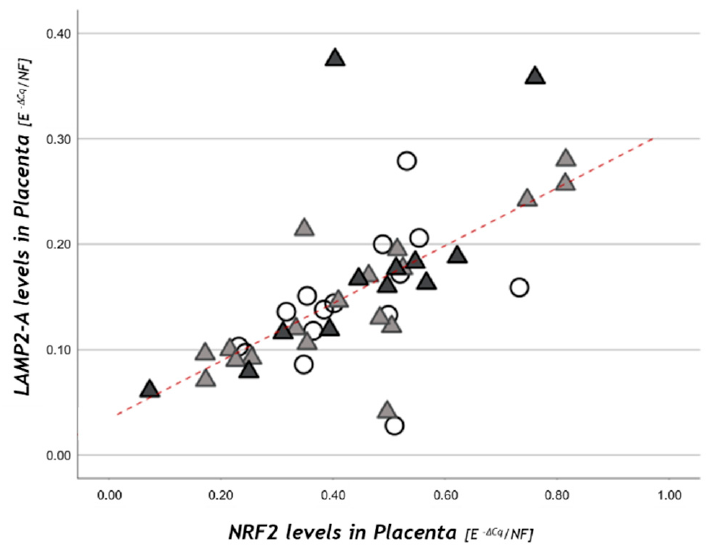
Figure 4. NRF2 placental levels in relation to LAMP-2A . Statistical analysis by the Spearman rank order correlation (r = +0.73, p < 0.001) in NW ( ○ ), OB GDM( − ) ( ▲ ), OB/GDM(+) ( ▲ ). In female, but not in male, placentas, a lower expression was recorded for CAT , GSS and GPX1 in OB GDM( − ) ( CAT : 0.070 ± 0.048; GSS : 0.133 ± 0.056; GPX1 : 0.141 ± 0.062) vs. NW ( CAT : 0.134 ± 0.040; GSS : 0.213 ± 0.368; GPX1 : 0.212 ± 0.660), though not significantly. Macroautophagy genes did not show any difference when dividing by both BMI/GDM and fetal